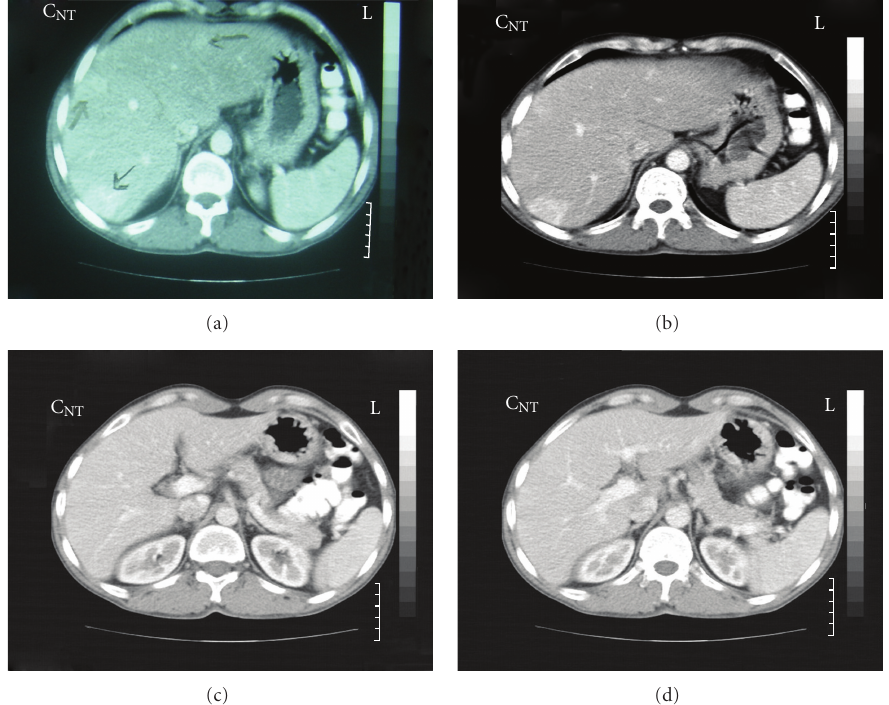
Figure 1: Pancreatic head mass lesion with peripheral enhancement (in favour of an islet cell tumor) and three enhancing lesions in both hepatic lobes, in favour of hypervascular metastasis.